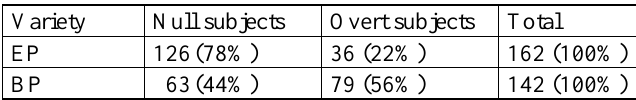
Table 1. Occurrences of null and overt subjects in EP and